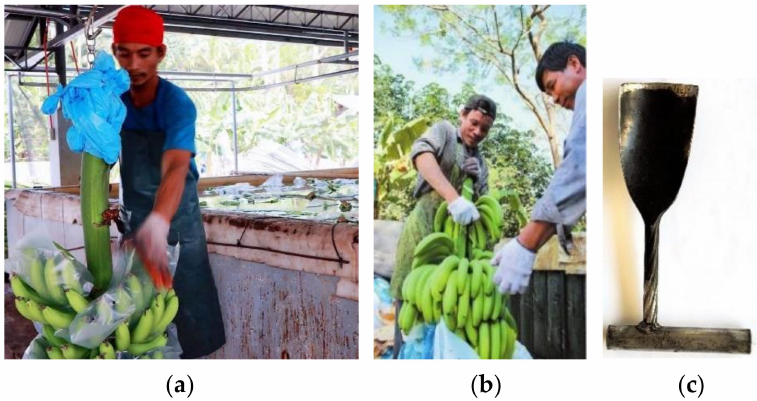
Figure 6. Traditional mode of banana de-handing, ( a ) in the post-harvest processing line and ( b ) in the fixed collecting station of the orchard. ( c ) A simple arc tool of banana